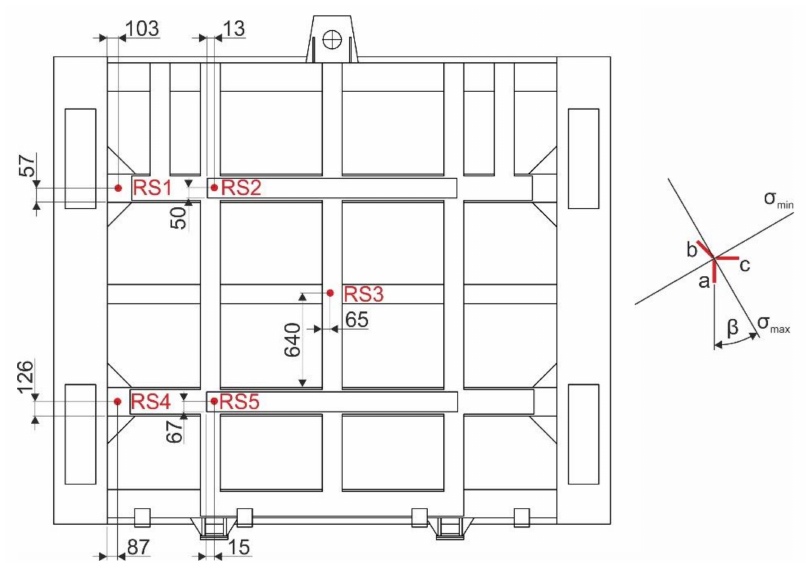
Figure 9. Position of strain gauge rosettes on the sluice gate.